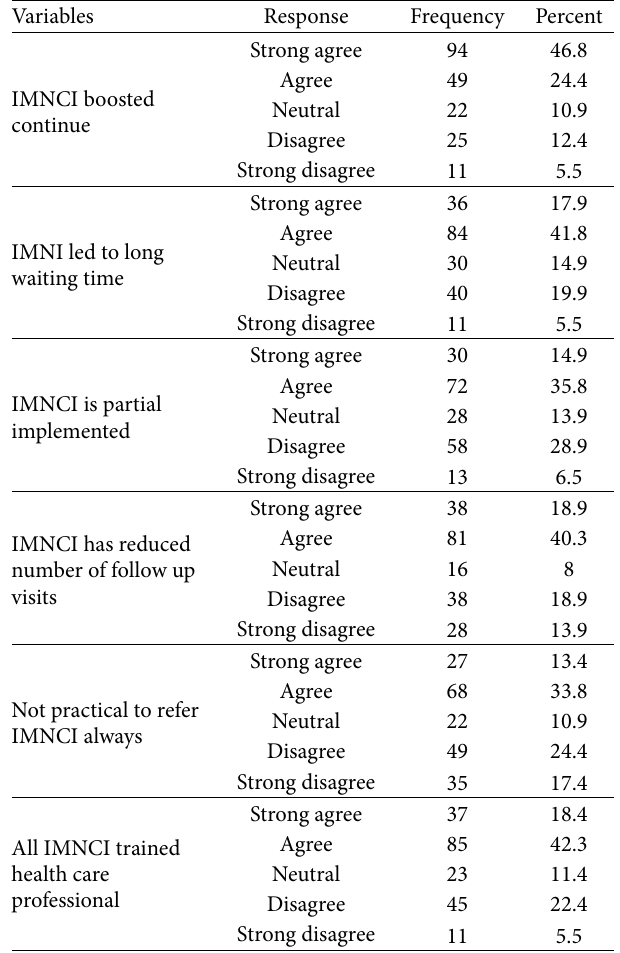
Table 11: The impact of IMCI on case management